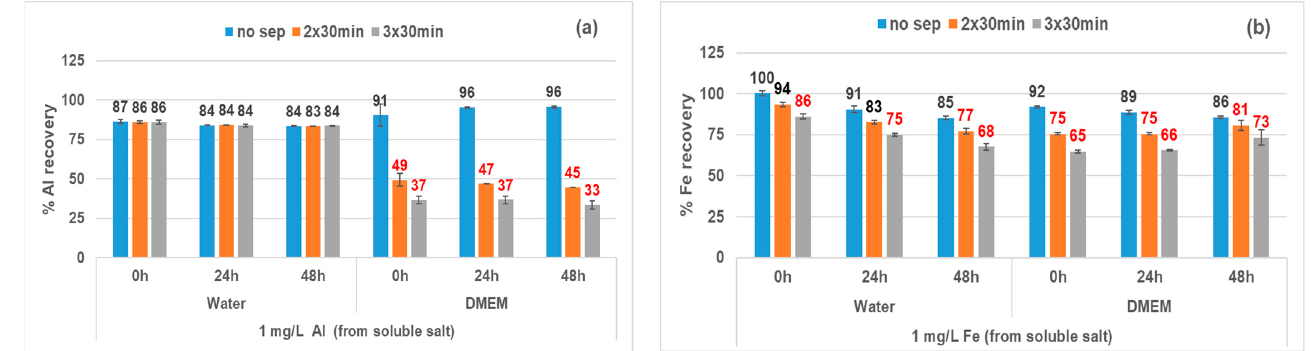
Figure 4. Evidence of Al ( a ) and Fe ( b ) sedimentation during control experiments with soluble salts: analyte loss increases as centrifugation time increases. Results (% recovered in supernatant) are presented as mean (standard deviation) of triplicates. no sep = No centrifugation, 2 × 30 min and 3 × 30 min centrifugation at 20,000× g .